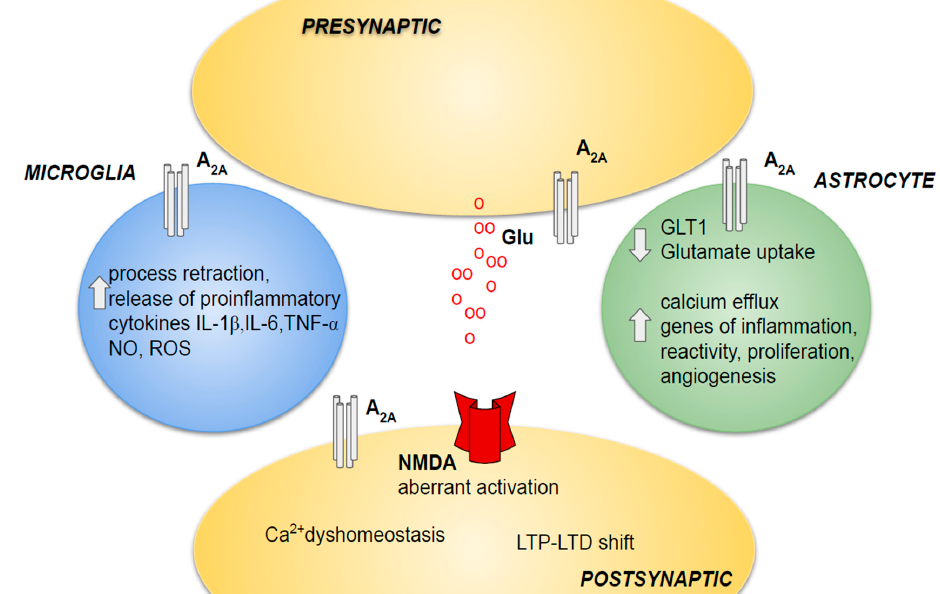
Figure 1. Schematic diagram illustrating the role of A 2A adenosine receptors in AD. While A 2A receptor hippocampal expression is generally protective, facilitating BDNF modulation of hippocampal synaptic transmission, in aging its overexpression takes place triggering deleterious synaptic effect causing an LTP-to-LTD shift and a reduction of hippocampal-dependent learning and memory processes. This was due to an increase A 2A - mediated glutamate release, mGluR5-dependent NMDA receptor activation, and calcium influx from overexpressed voltage-dependent calcium channels [58–61]. A similar synaptic plasticity shift, A 2A receptor-dependent, was observed in the hippocampus of aged and APP/PS1 animals [61,62]. It has been hypothesized that this phenomenon may be due to a shift in receptor cross-talk involving A 2A -A 1 heteromers, with the loss of A 2A -mediated inhibition of presynaptic inhibitory A 1 receptors in aged versus young rats and a direct facilitatory effect of A 2A stimulation [63]. Specifically, an increase in A 2A expression has been found in hippocampal neurons of aged or AD animal models as well as in astrocytes of AD patients and aged mice [62,64–69]. Interestingly, an increased hippocampal density of A 2A receptors has also been observed in AD patients [61,70,71] (Table 3). Table 3. Upregulation of A 2A adenosine receptors in aged or animal models of AD and in AD patients. Aged/Animal Models of AD/AD Patients Tissue/Cell